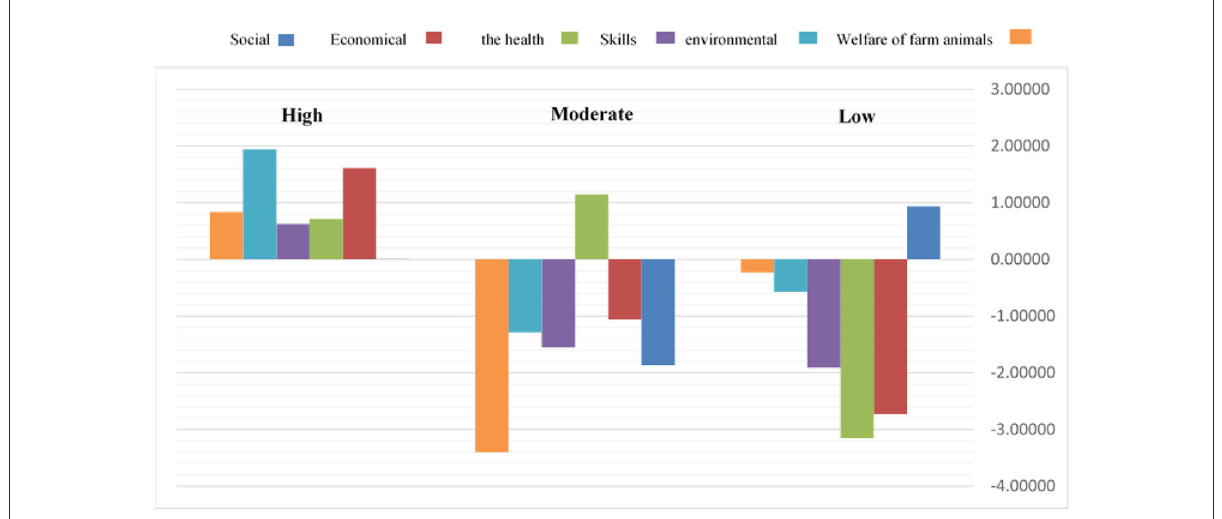
FIGURE3 Grouping of respondents according to food literacy, the result of the final